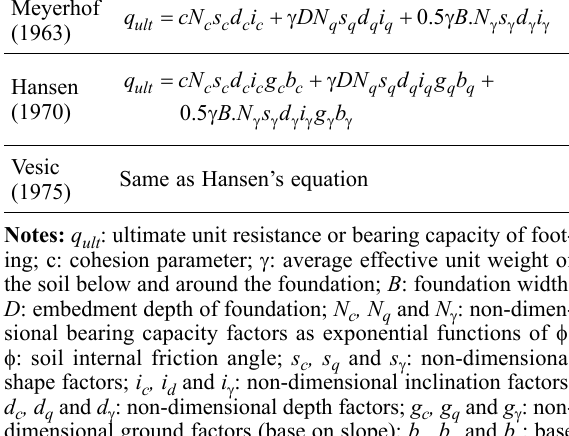
Table 1. General forms of the classical prediction equations for the bearing capacity of shallow foundations Reference Terzaghi